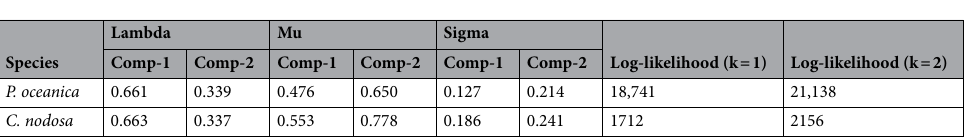
Table 1. Distribution parameters of the mixture models of CpG O/E in the two seagrass transcriptomes. Higher log-likelihood statistics indicates the model that better fits the density